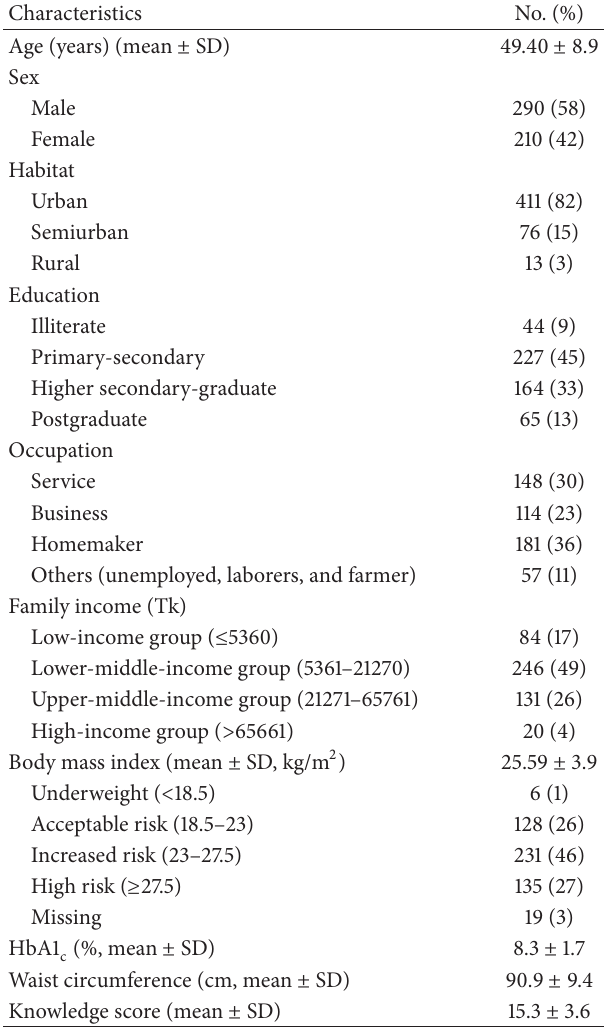
Table 1: Characteristics of patients ( 𝑛 = 500